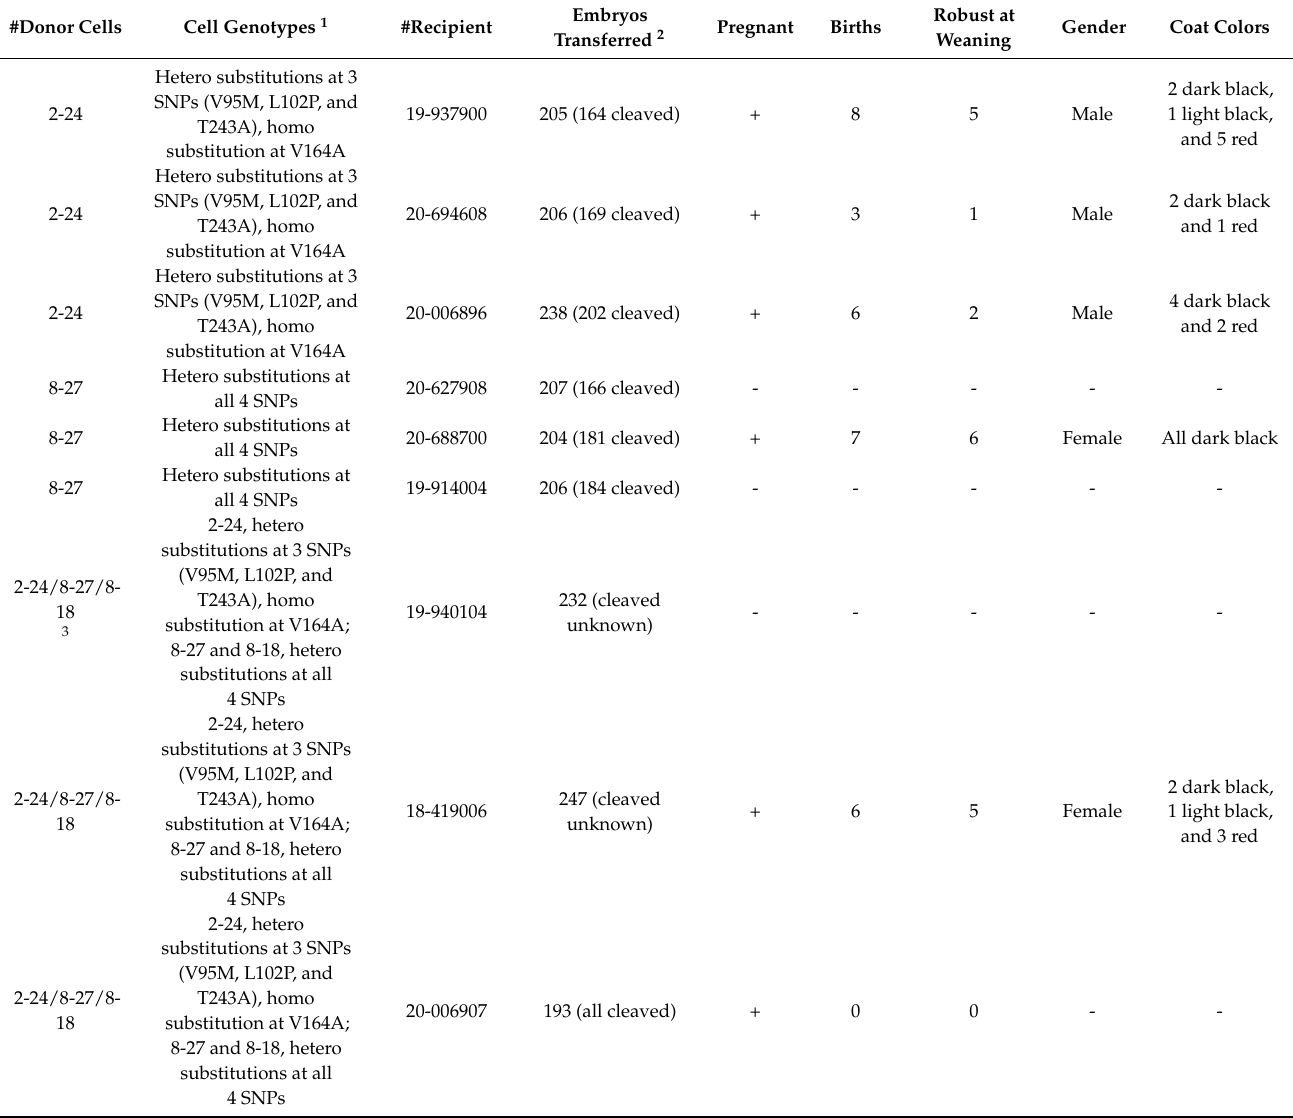
Table 1. SCNT summary for MC1R -modified